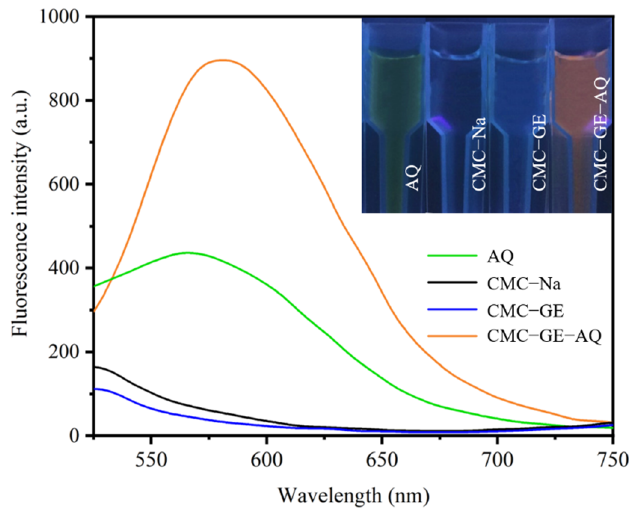
Figure 3. Fluorescence spectra and (inset) fluorescence photographs of AQ, CMC−Na, CMC−GE and CMC−GE−AQ solution. (CMC−GE−AQ: 1.5 × 10 −4 g mL −1 ; solvents: DMF/H 2 O solution ( v / v = 8/2, pH = 7); excitation wavelength: 425 nm; excitation slit: 5 nm.)